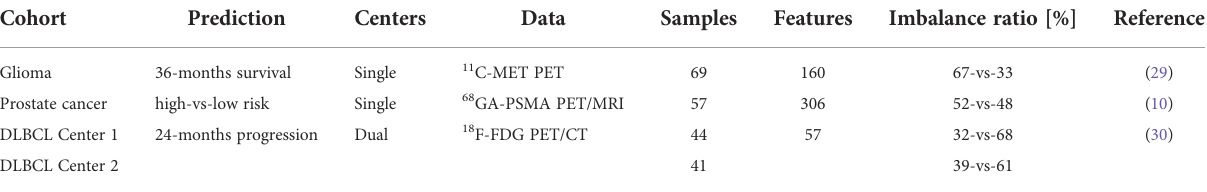
TABLE 1 Characteristics of cancer cohorts used in